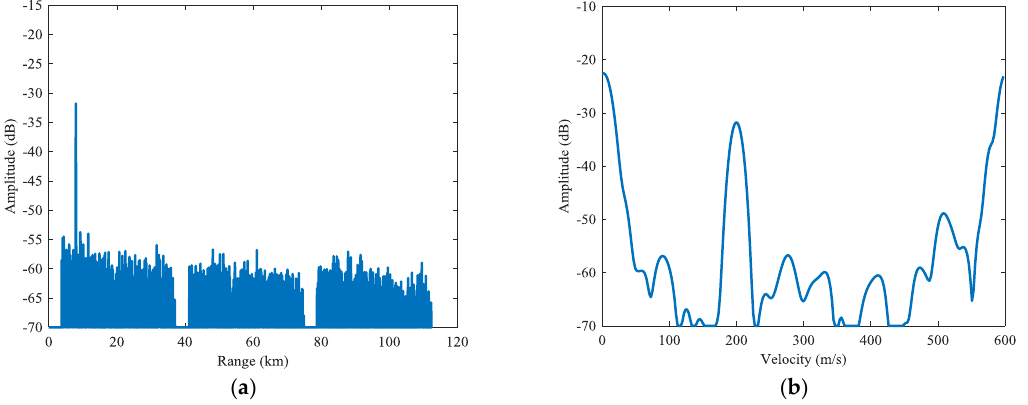
Figure 11. Cross profiles of Target 1 for the complete PD process: ( a ) range profile, ( b ) Doppler profile.